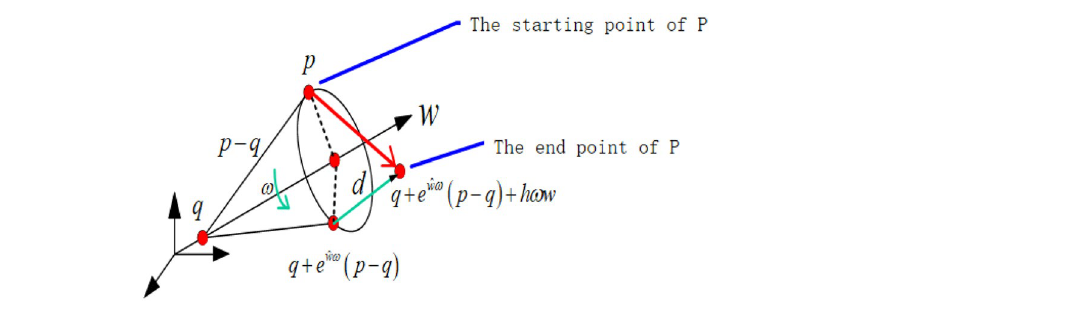
Figure 3. The decomposition diagram of screw